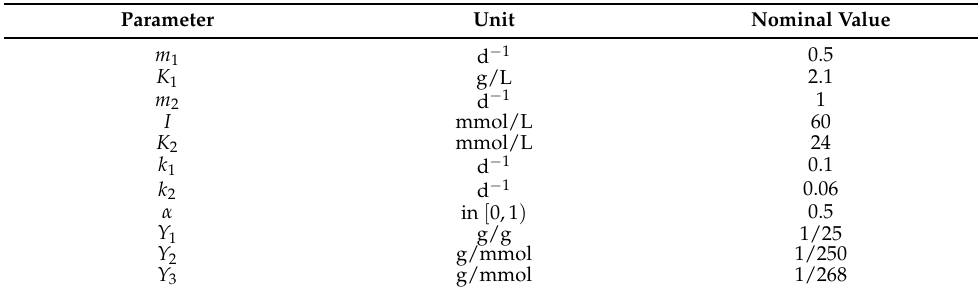
Table 8. Parameters values for the